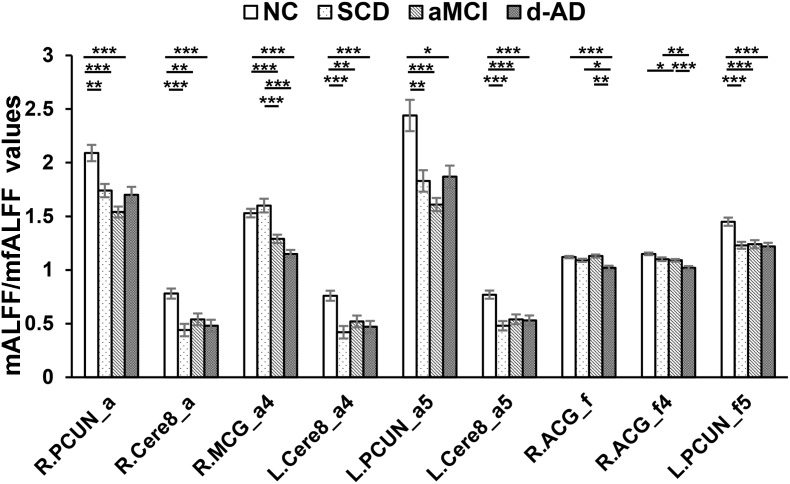
Decreased ALFF and fALFF patterns tendency in patient groups. ∗ represents significant level P < 0.05, ∗∗ means significant level P < 0.01, and ∗∗∗ means significant level P < 0.001. L., left; R., right; R.PCUN, Precuneus_R (aal); R.Cere8, Cerebelum_8_R (aal); R.MCG, Cingulum_Mid_R (aal); L.PCUN, Precuneus_L (aal); R.ACG, Cingulum_Ant_R (aal). ALFF analysis in full band (0.01–0.1 Hz); a4, ALFF analysis in slow-4 band (0.027–0.073 Hz); a5, ALFF analysis in slow-5 band (0.01–0.027 Hz); f, fALFF analysis in full band; f4, fALFF analysis in slow-4 band; f5, fALFF analysis in slow-5 band.